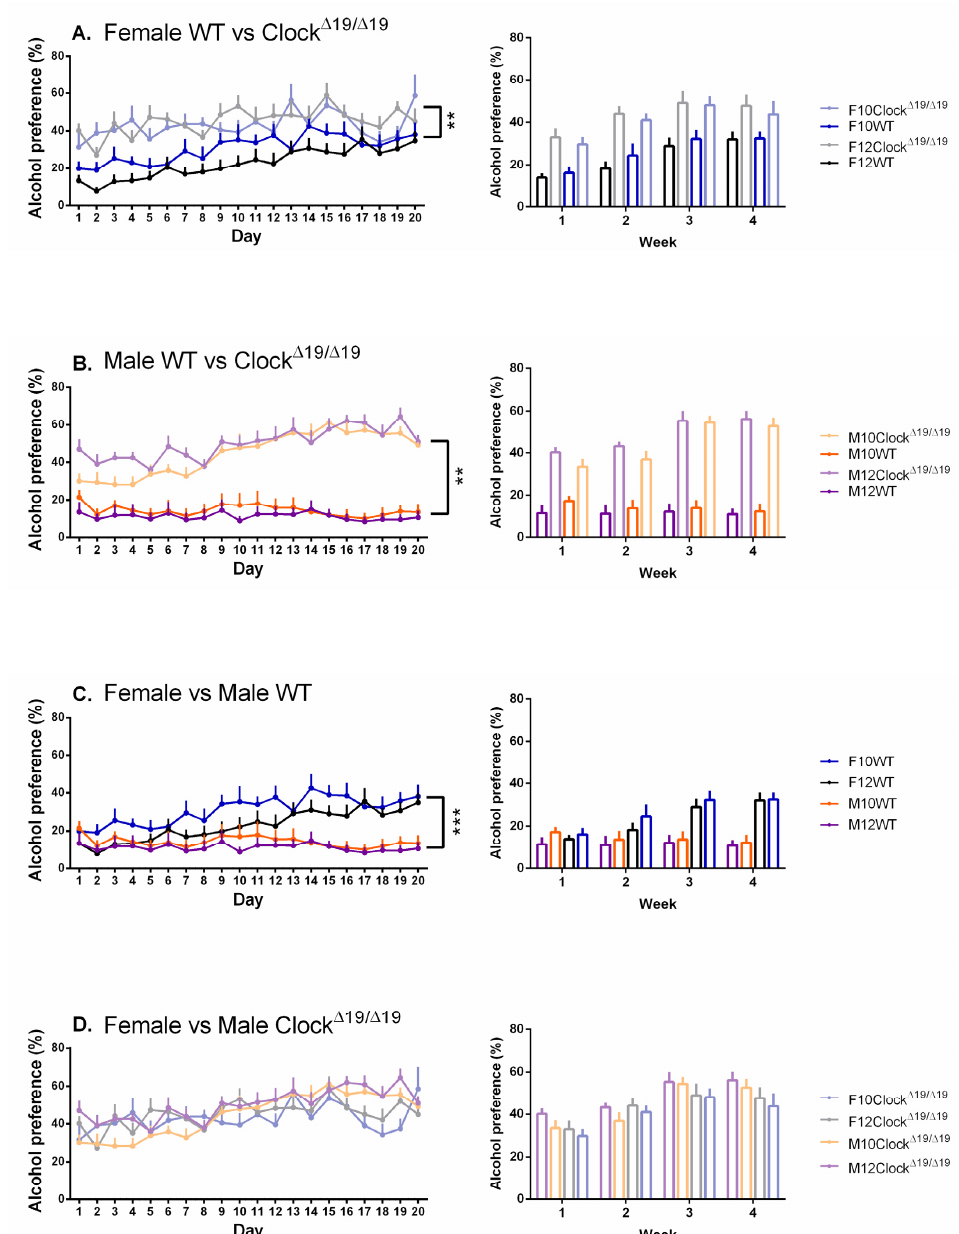
Figure 3. Alcohol preference in mice is influenced by sex, genotype, and number of drinking days, but not L:D cycle. ( A ). Compared to female WT mice, female Clock ∆ 19/ ∆ 19 mice demonstrated enhanced alcohol preference. Over time, female WT alcohol preference increased such that by day 20 they were no longer different from their Clock ∆ 19/ ∆ 19 counterparts. ( B ). Male Clock ∆ 19/ ∆ 19 mice demonstrated enhanced alcohol preference compared to male WT mice, a difference that was maintained across the 20-day testing period. ( C ). Compared to male WT mice, female WT mice demonstrated alcohol preferences that increased over time such that by day 20 the difference between male and female mice was statistically significant. ( D ). Clock ∆ 19/ ∆ 19 mice exhibited alcohol preferences that were not influenced by sex or L:D cycle. F = females, M = males; 12 = 12:12 L:D cycle, 10 = 10:10 L:D cycle; WT = wild-type. Darker tones are WT mice and lighter tones are Clock ∆ 19/ ∆ 19 mice. Black = female 12:12 L:D group, blue = female 10:10 L:D group, purple = male 12:12 L:D group, orange = male 10:10 L:D group. ** = p < 0.01, *** = p <